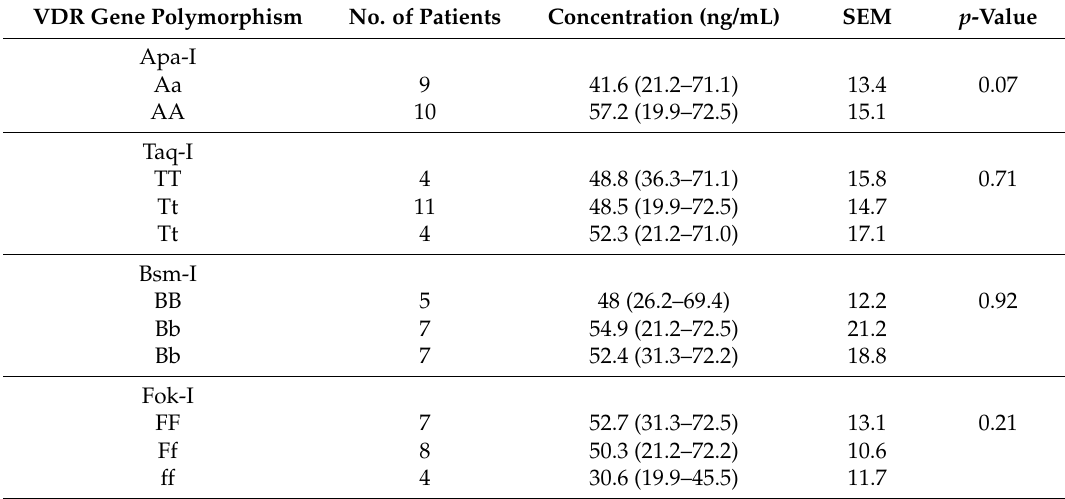
Table 4. Vitamin D 3 concentration depending on VDR receptor polymorphisms (Apa-I, Taq-I, Bsm-I and Fok-I) in ASD